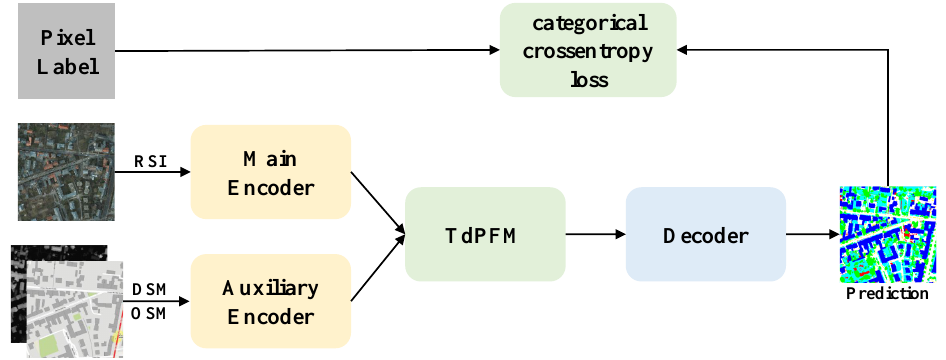
Figure 2. The overall structure of